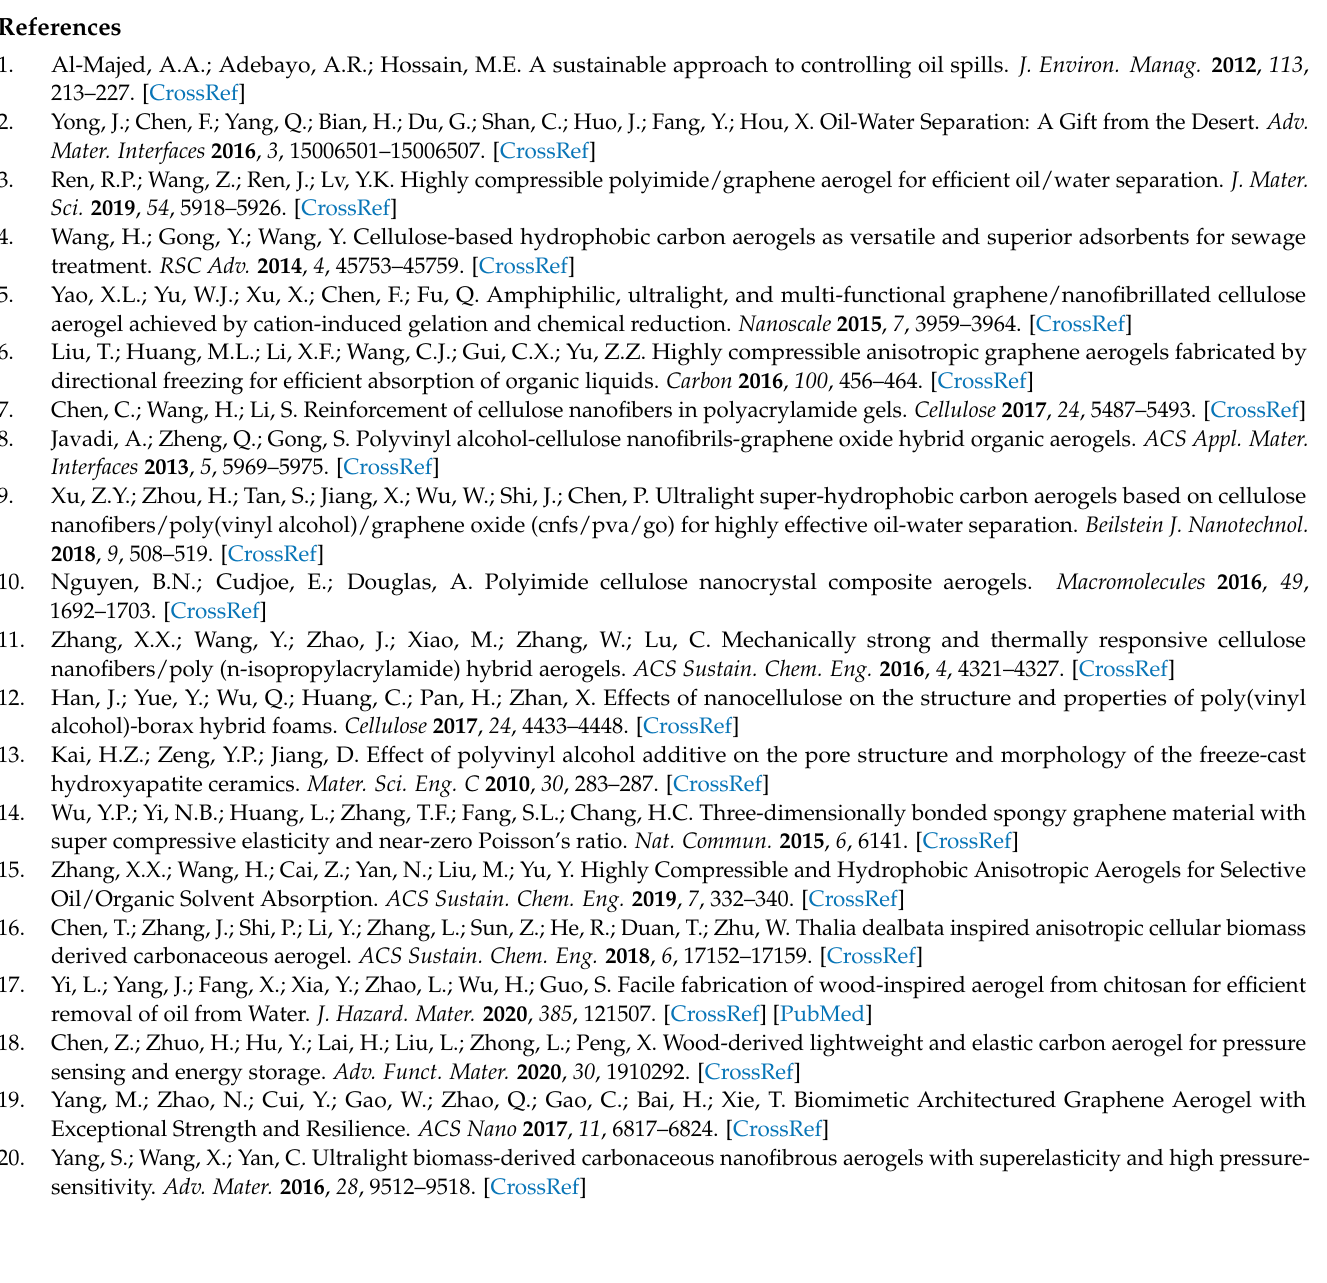
Figure S5: Comparison between MGTPA with different GO concentrations in their compression– recovery